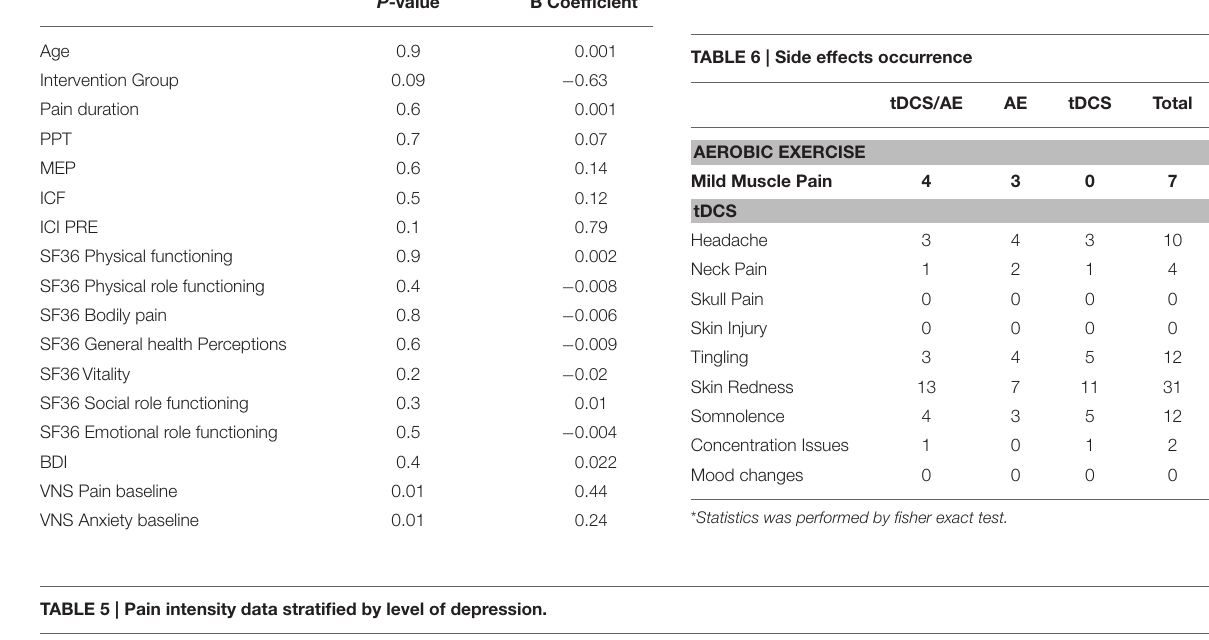
Frontiers in Human Neuroscience |